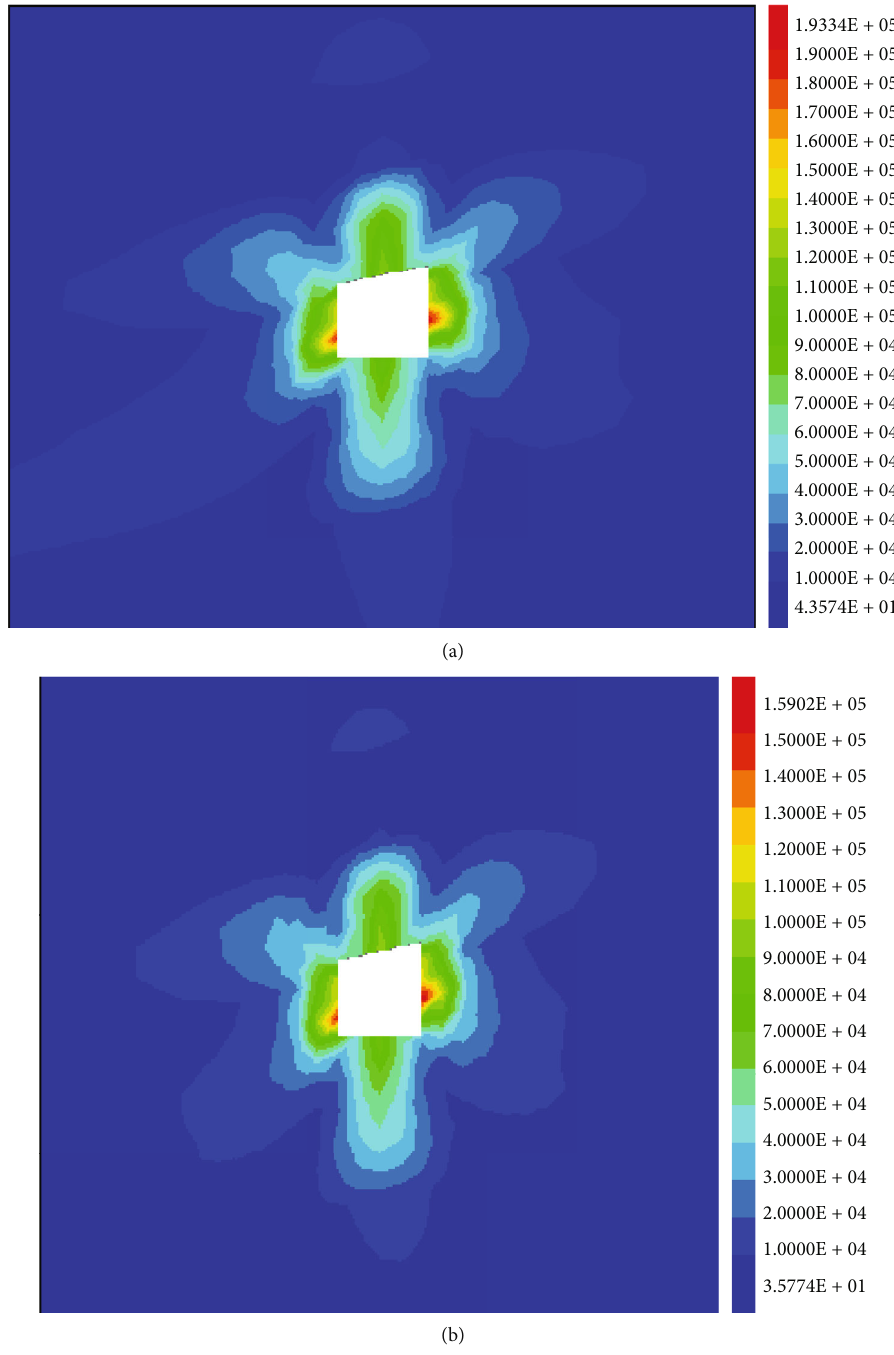
Figure 15: Elastic strain energy nephogram before and after optimization. (a) Original support. (b) After